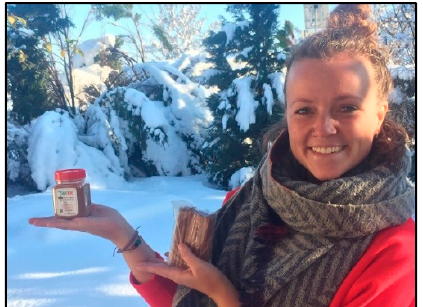
Figure 14. Cinnamon packaging with a GI